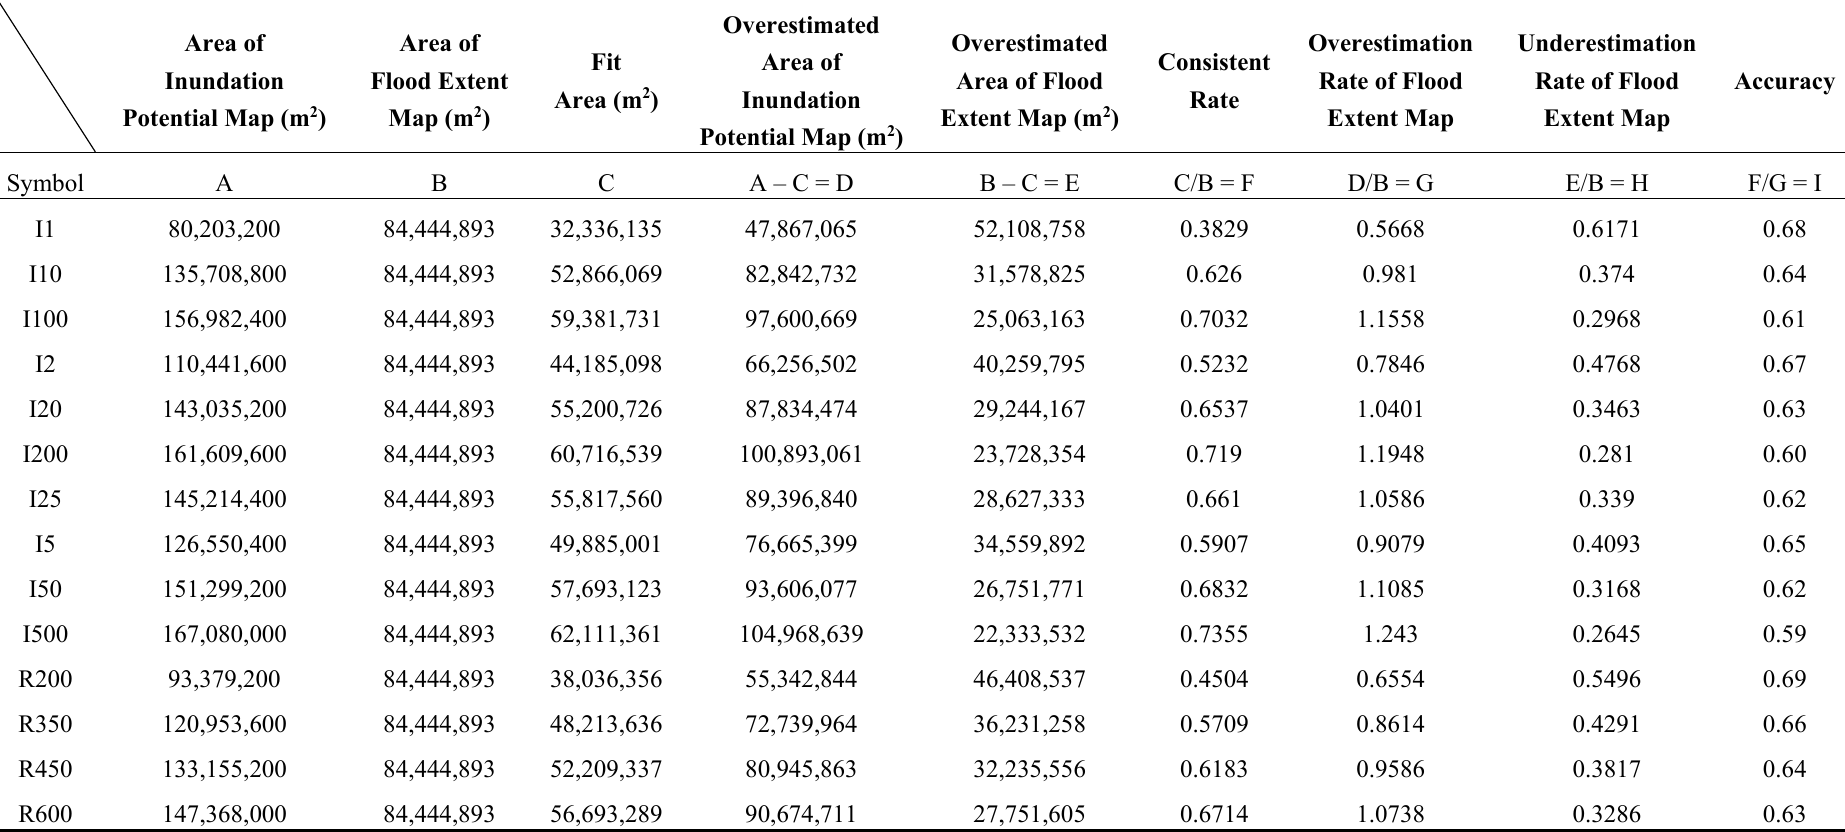
Table 2. The accuracy between the flood extent map and different inundation potential